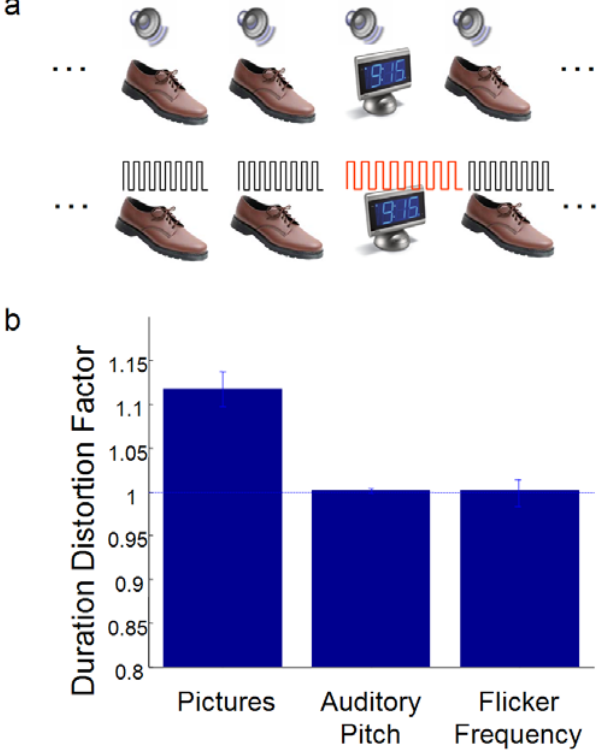
Figure 2. Are accompanying temporal judgments distorted with duration? (a) Experimental details are the same as Figure 1, except that the visual sequence is accompanied by an auditory beep (top), or the photographs are flickered. (b) Mean DDF values for the visual oddball task (averaged from Figure 1c), auditory pitch (n=6) and flicker rate (n=6) discrimination tasks.